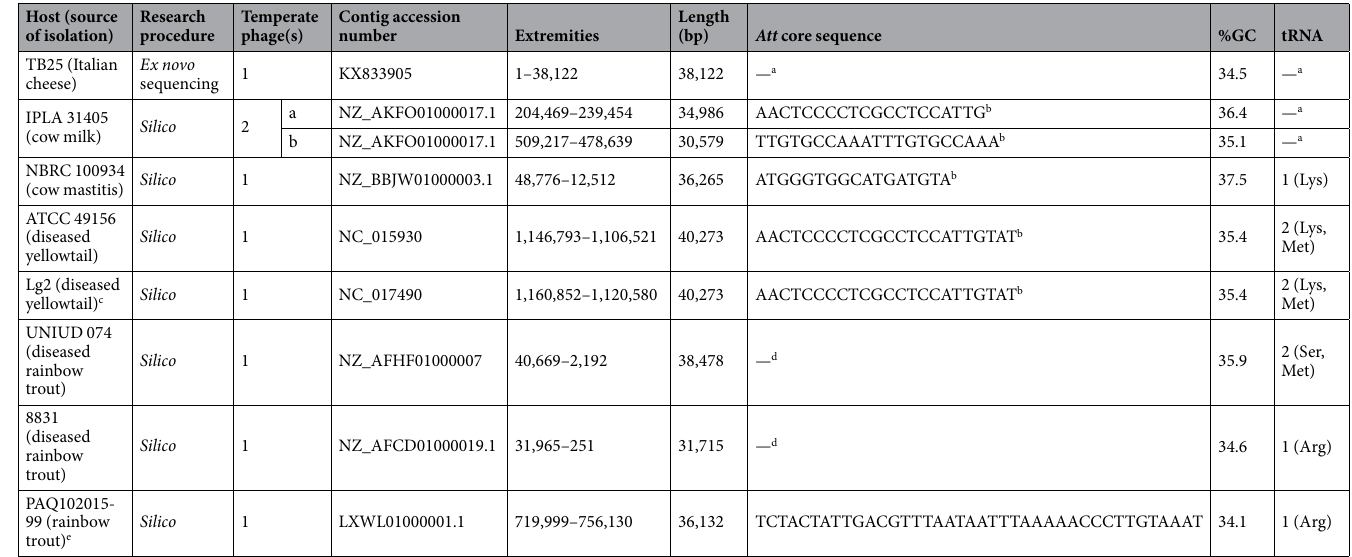
Table 2. Position, orientation, length, att core sequence, %GC and tRNA of the temperate phages in different L. garvieae genomes. a Not found. b Att core has been determined by searching for perfect direct repeats in the vicinity of the phage genome. c ATCC 49156 and Lg2 genomes are co-linears (99% sequence identity). d None sequence more than 10 bp were found. e 8831 and PAQ102015-99 genomes are 98% symmetric identity (NCBI data). Lys: lysine, Met: methionine, Ser: serine, Arg: